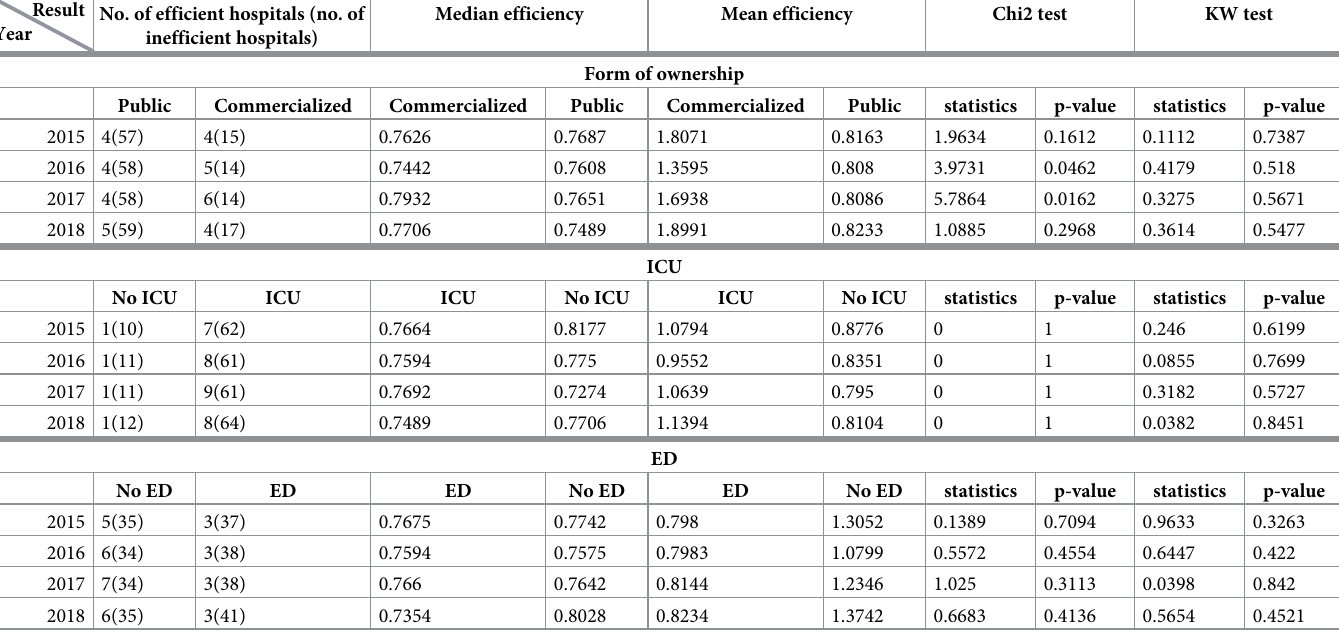
Table 8. Efficiency of hospitals with respect to the form of ownership, ED and ICU ( traditional approach). Result